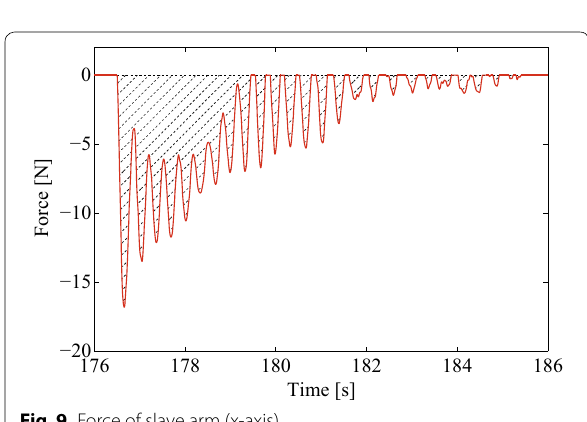
Fig. 9 Force of slave arm